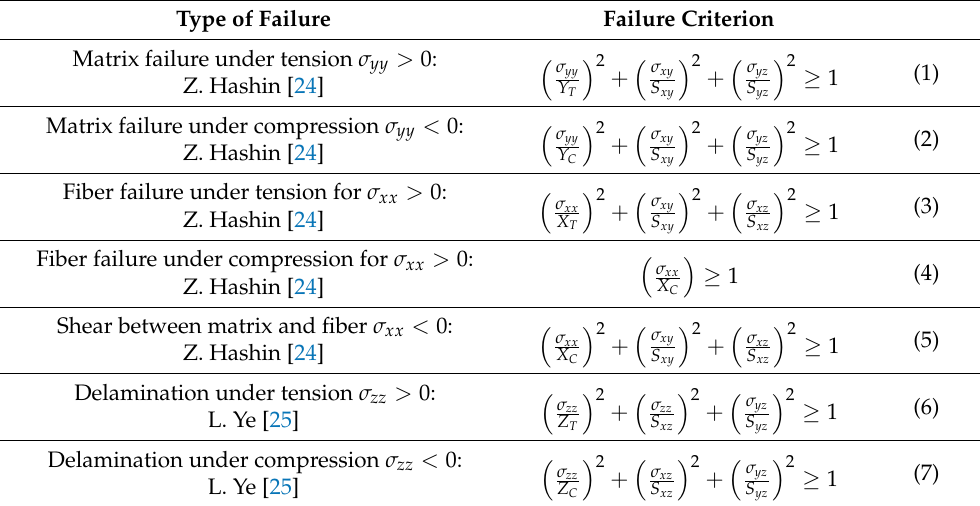
Table 1. Types and failure criteria of layered composite materials. Type of Failure Failure